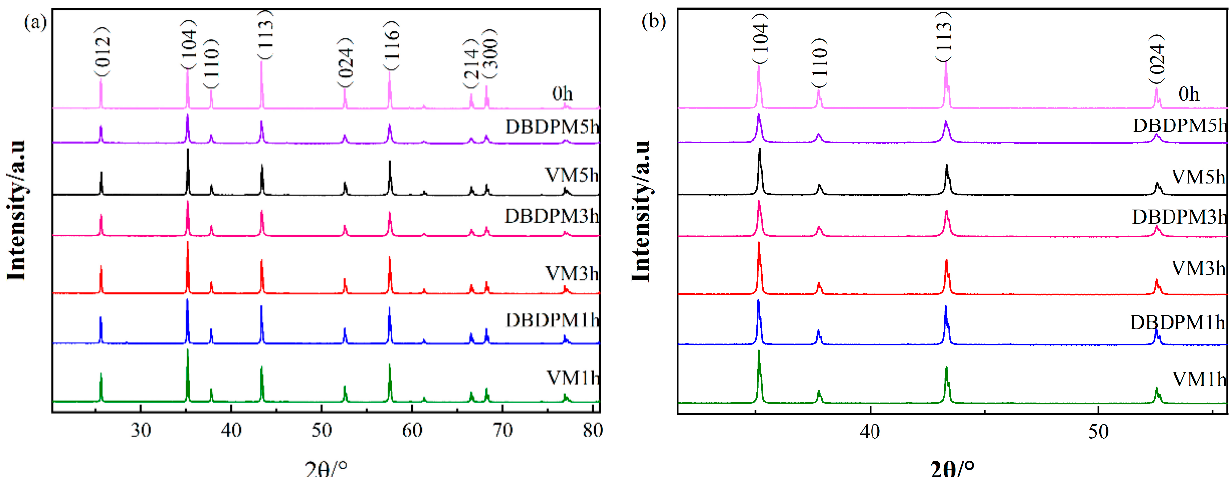
Figure 1. XRD patterns of Al 2 O 3 powder after different milling times: ( a ) global drawing and ( b ) partial enlarged drawing. Table 2. FWHM of Al 2 O 3 powder after different milling times.